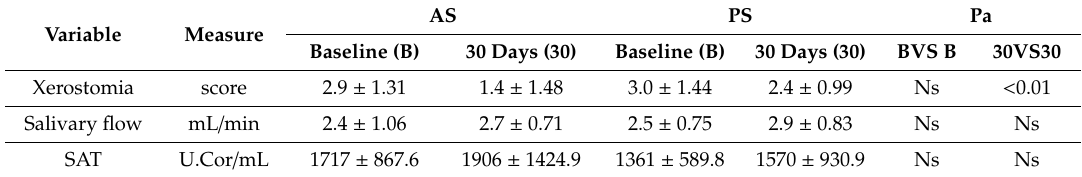
Table 3. Xerostomia score, salivary flow, saliva antioxidant capacity (SAT): mean values ± SD at baseline and after 30 days of treatment, with the relative statistical significance (pa) for each variable between the two groups.